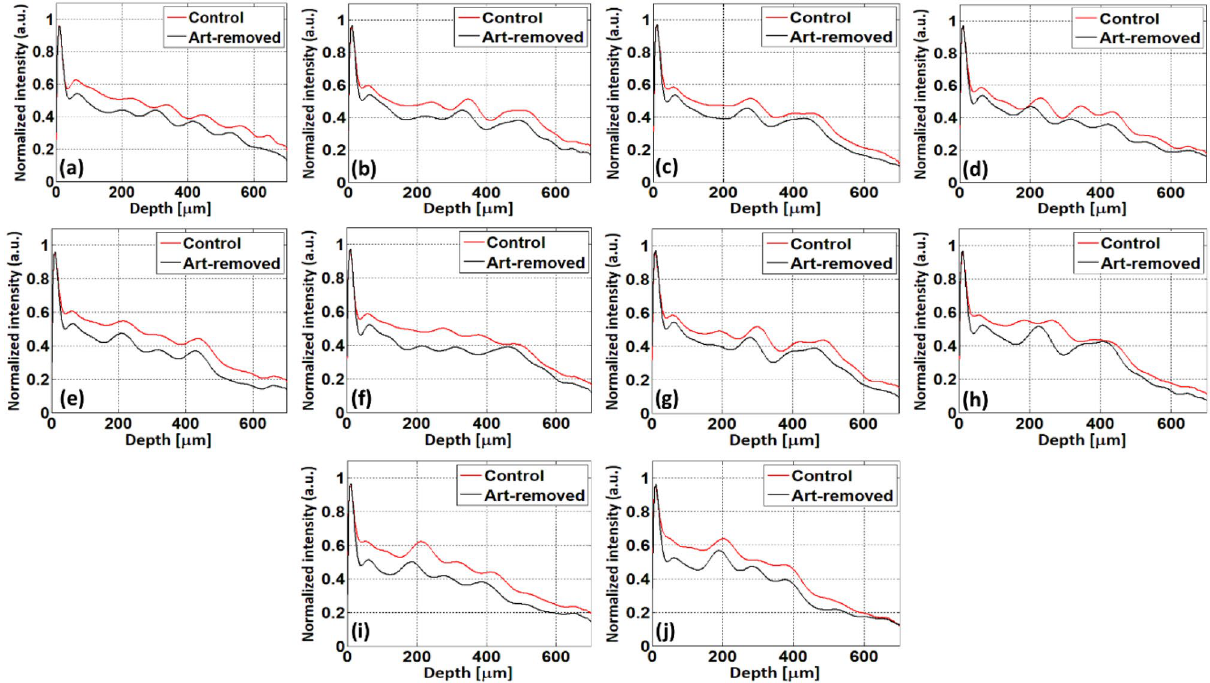
Figure 8. Back-scattered intensity difference of control and art-removed nail images. Images ( a – j ) for back- scattered intensity difference of nail 1 to 10.